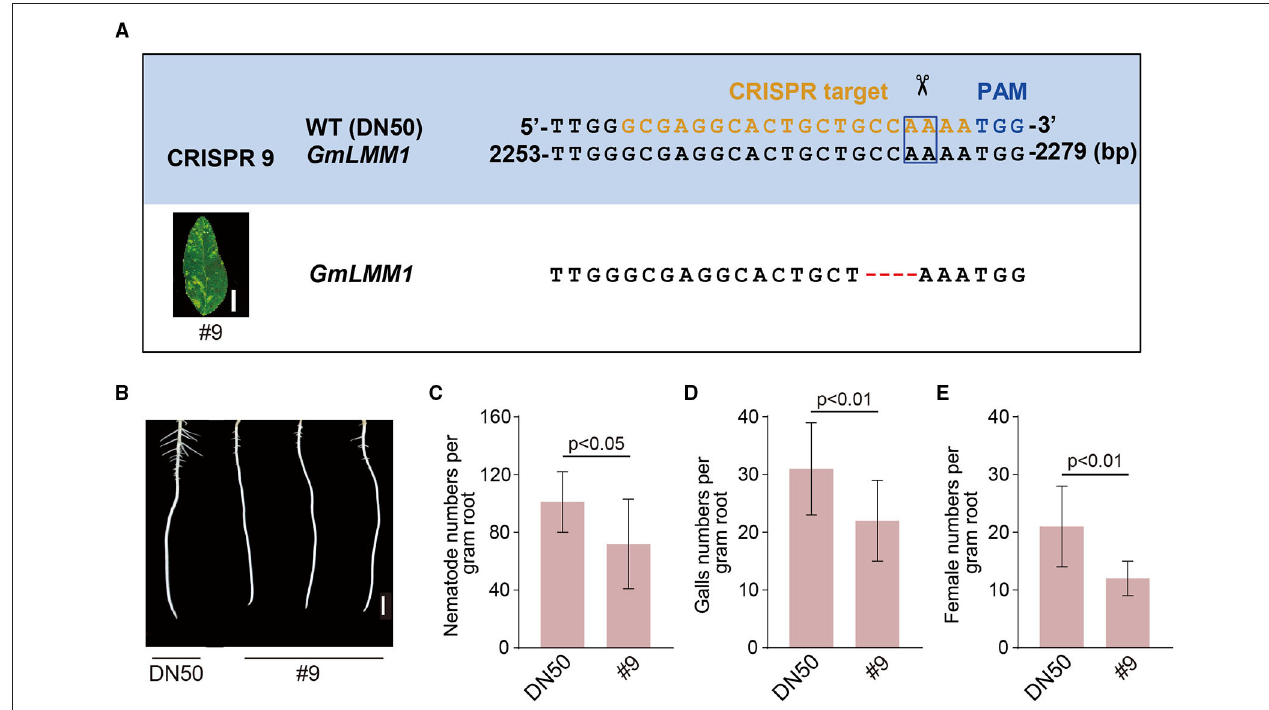
FIGURE 2 | Editing of the GmLMM1 causes the resistance to M. incognita . (A) Editing of GmLMM1 by CRISPR/Cas9. The CRISPR target sequence is shown in orange, and the corresponding protospacer adjacent motif (PAM) site is shown in blue. The box indicates the putative sites shear cut by cas9. (B) Phenotype appearance of the line #9 mutant root. Scale bar presents 1cm. (C) M. incognita parasites numbers per gram of soybean roots at 7 dpi. (D,E) M. incognita gall (D) and female (E) numbers per gram of soybean roots at 30 dpi. At least three biological replicates of (C–E) were performed, and the similar results were obtained. Data are presented as the mean ± S.D., n ≥ 10; Student’s t